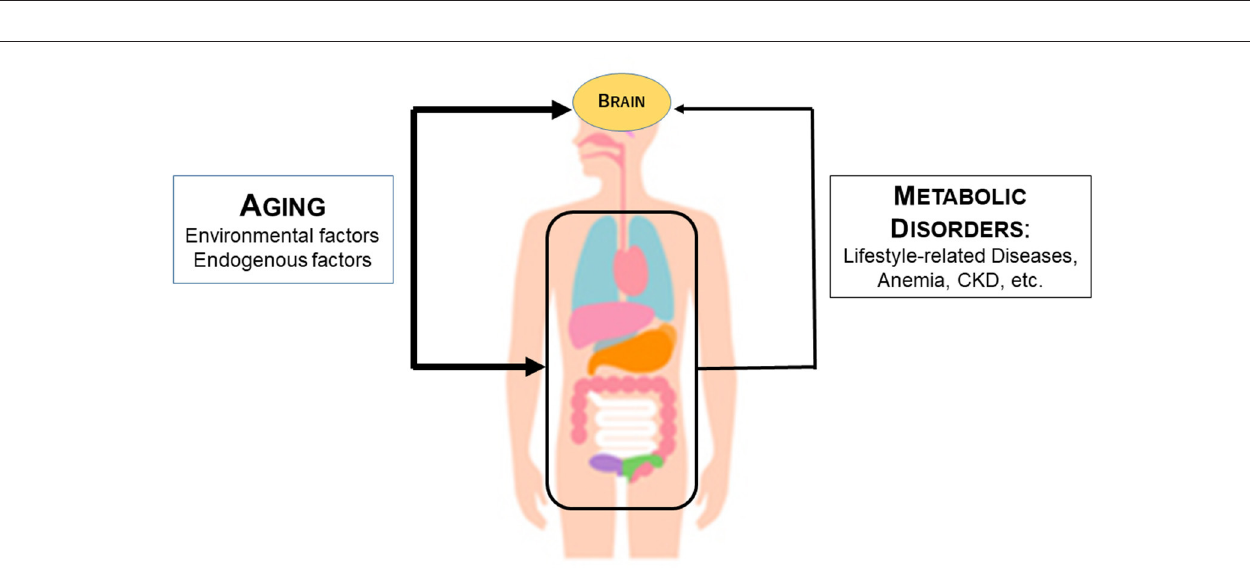
FIGURE 6 | Mechanism by which aging and systemic metabolic disorders affect cerebral atrophy. The thickness of the arrow indicates the strength of the influence. The thicker line of age than the line of metabolic disorders including anemia indicates that age has a stronger influence on metabolic atrophy than the metabolic disorder